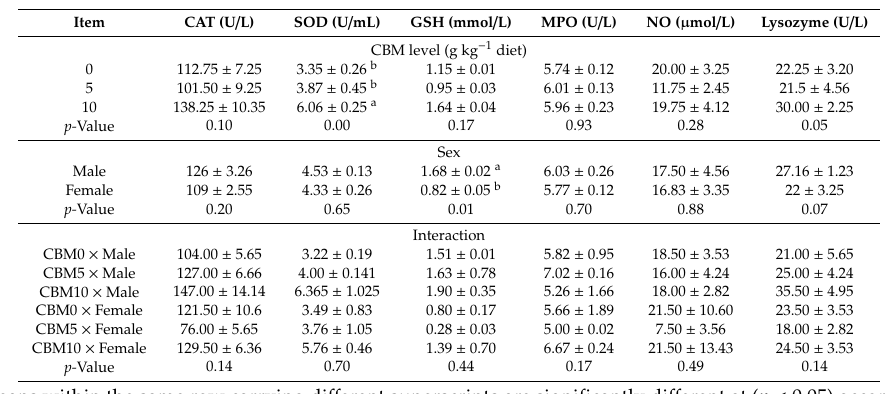
Table 5. E ff ect of dietary supplementation of cacao bean meal (CBM) on the antioxidant and immune status of broodstock C. auratus